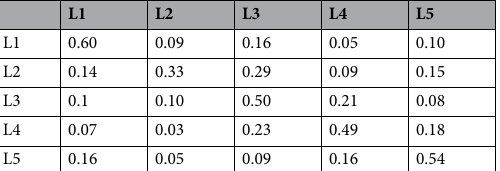
Table 1. Estimated transition matrix at round 10 in the homogeneous treatment. The states are the five levels of contribution: L